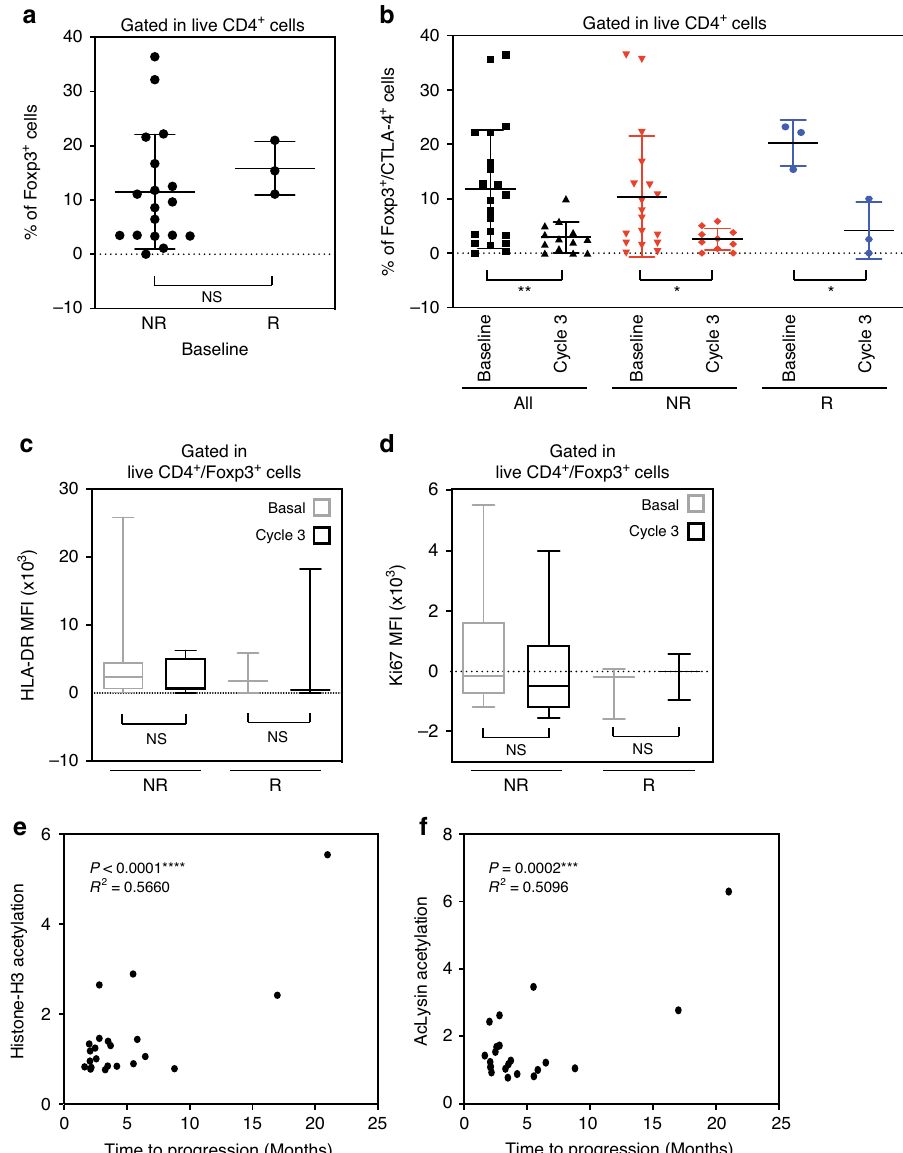
Fig. 4 Correlative analyses. a Flow cytometry quanti fi cation of tumor Foxp3 + CD4 + Tregs taken from patients before treatments (Baseline) in non- responders (NR) versus responders (R) ( n = 21). b Flow cytometry quanti fi cation of tumor Foxp3 + CTLA-4 + CD4 + Tregs in all the patients (black), non- responders (NR, red) and responders (R, blue), before (Baseline) and after 3 cycles of treatment (Cycle 3). c Flow cytometric quanti fi cation of HLA-DR ( c ) and Ki67 ( d ) expression in Foxp3 + CD4 + T-cells ( n = 12). The markers represent the 5 th percentile, fi rst quartile, median, third quartile, and 95 th percentile values, respectively ( c , d ). Two-tailed Pearson correlation between the fold increase in day 10-12 versus day 1 of ( e ) acetyl histone H3 (AcH3) and ( f ) acetyl lysine (AcLys) in lymphocytes and time to progression in months ( n = 22). Data are presented as the mean ± SD. Statistical signi fi cance is indicated by p -values as p ≤ 0.05; ** p ≤ 0.01; *** p ≤ 0.001; **** p ≤ 0.0001; NS = not signi fi cant and was determined by two-tailed Mann-Whitney test for a , b (All and NR), with two-tailed Wilcoxon test for c , d , and by two-tailed paired T test for B